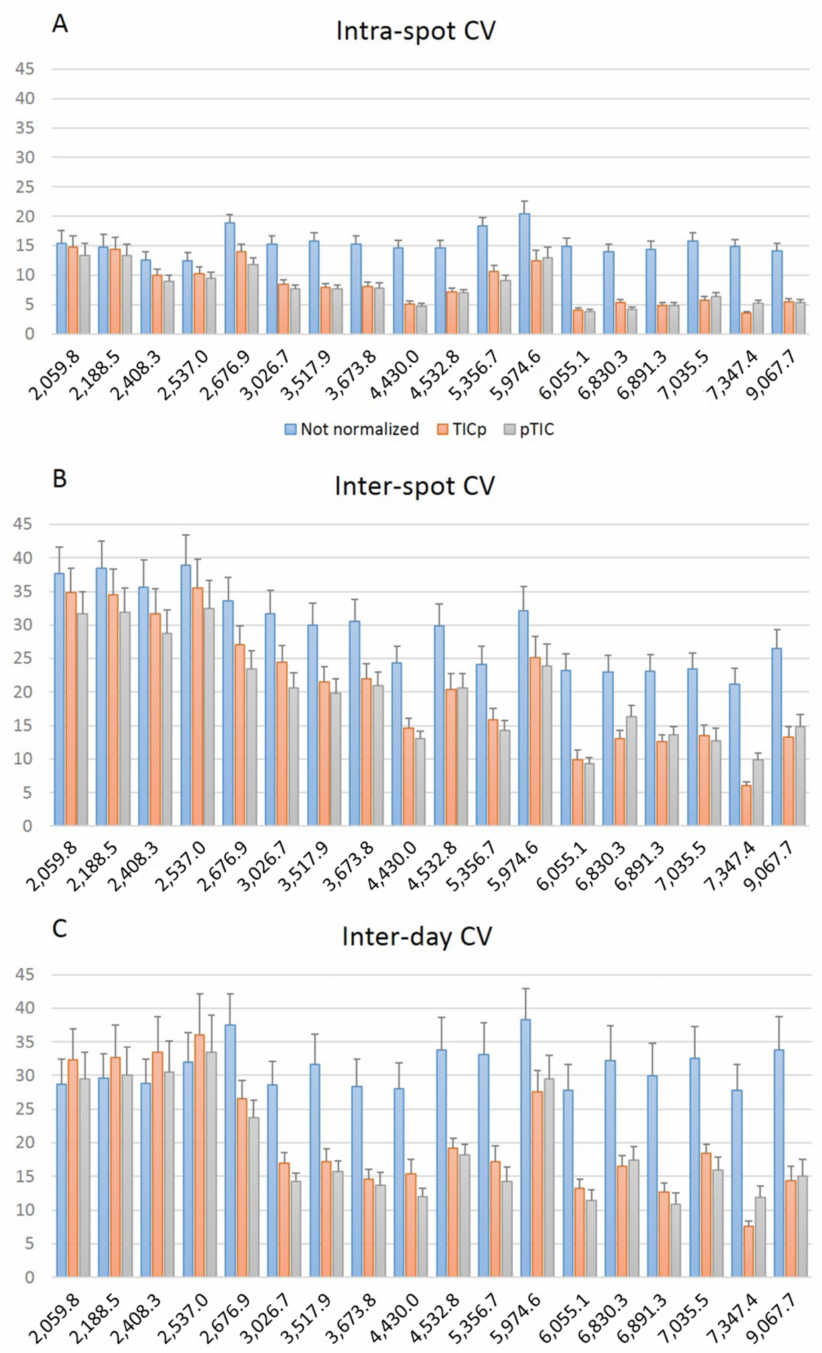
Figure 4. Comparison of the average coefficient of variation (CV) for the peak intensity of the 18 common peaks analyzed at intra-spot ( A ), inter-spot ( B ) and inter-day ( C )